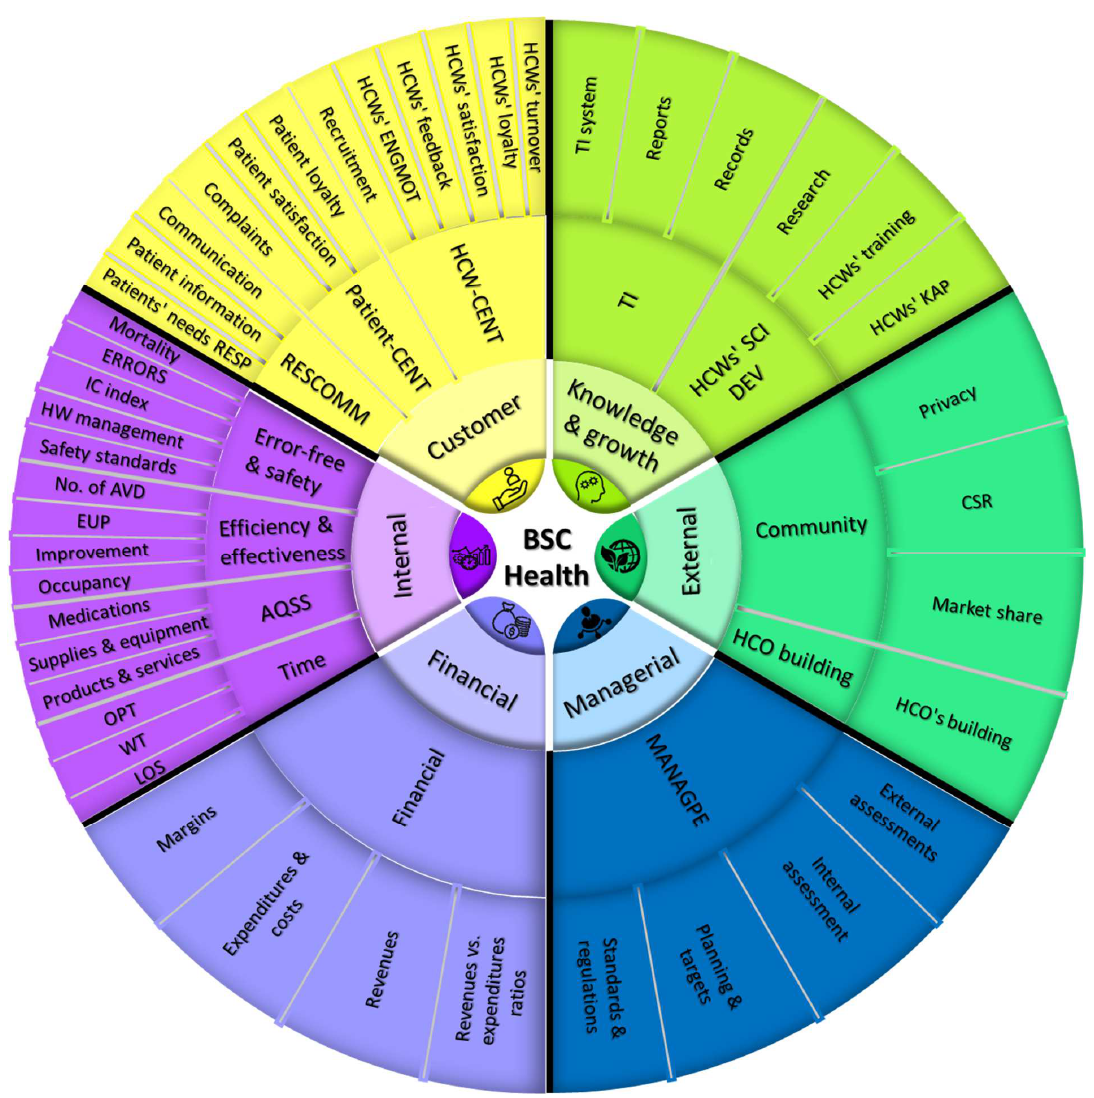
Figure 3. A summary of BSC perspectives in health care and their contents [12]. Figure legend: Summary of BSC perspectives and the underlying major and minor subdimensions for the PE of HCOs. Note: BSC, balanced scorecard; HCWs, health care workers; HCO, health care organization; IC, infection control; HW, health waste; WT, waiting time; LOS, length of stay; KAP knowledge, attitude, and practices; TI, technology and information; CSR, corporate social responsibility; ERRORS, errors, accidents, and complications; No. of AVD, number of admissions, visits, and diseases; EUP, efficiency, utilization, and productivity; AQSS, availability and quality of supplies and